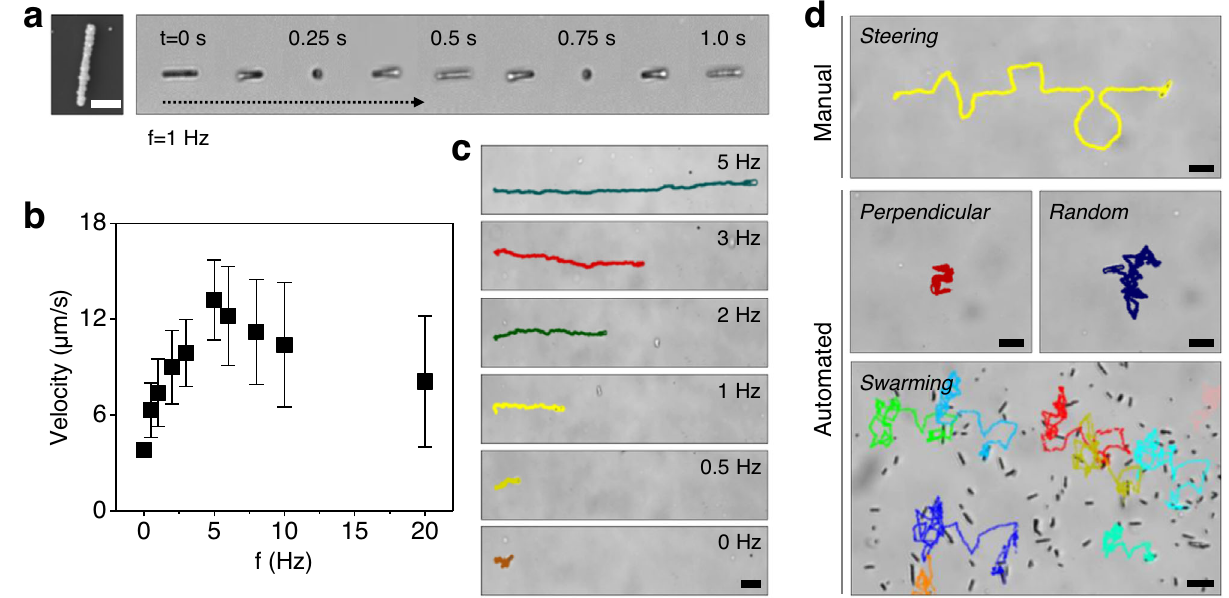
fi eld frequency ( b ) and representative propulsion trajectories ( c ). Scale bar is 10 µ m. d Manualandautomatedlocomotionmodesandmagneticswarmboosting for programmed navigation (5mT, 5Hz). Scale bars are 10 μ m. Data in b are pre- sented as mean ± standard deviation ( n